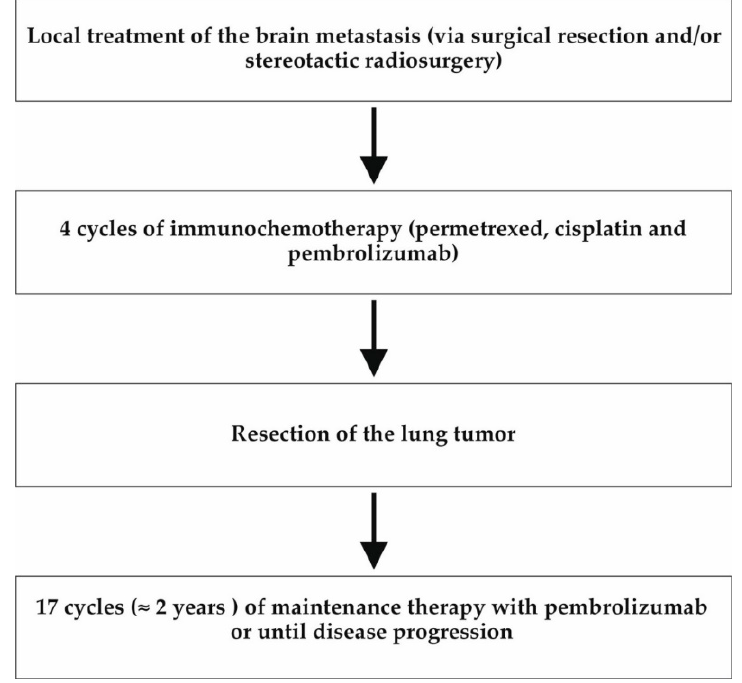
Figure 2. Flow chart of the patients’ treatment plan. All three patients were initially treated according to the following treatment algorithm in line with the ASCO guidelines [7]. At the beginning, local therapy of the brain metastasis was performed by means of neurosurgery or stereotactic radiosurgery. Afterwards, the patients received four cycles of immunochemotherapy followed by resection of the primary lung tumor. This was followed by maintenance immunotherapy for 2 years (or until disease progression).